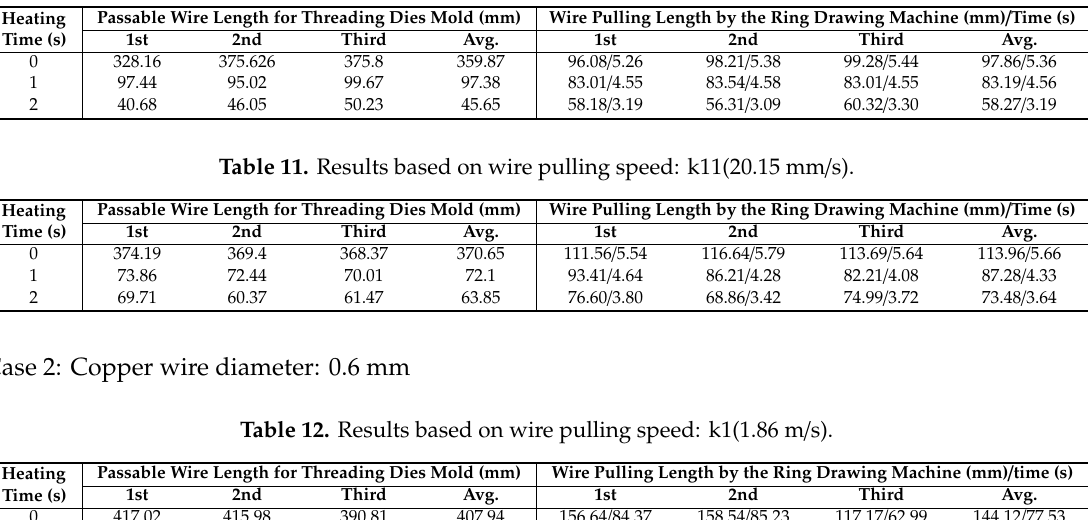
Table 10. Results based on wire pulling speed: k10(18.25 mm / s).